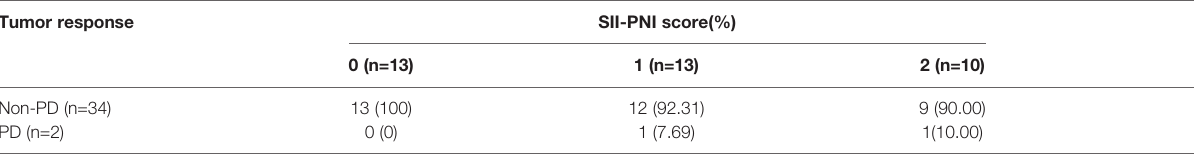
TABLE 2 | Relationship between tumor response and the SII-PNI score.